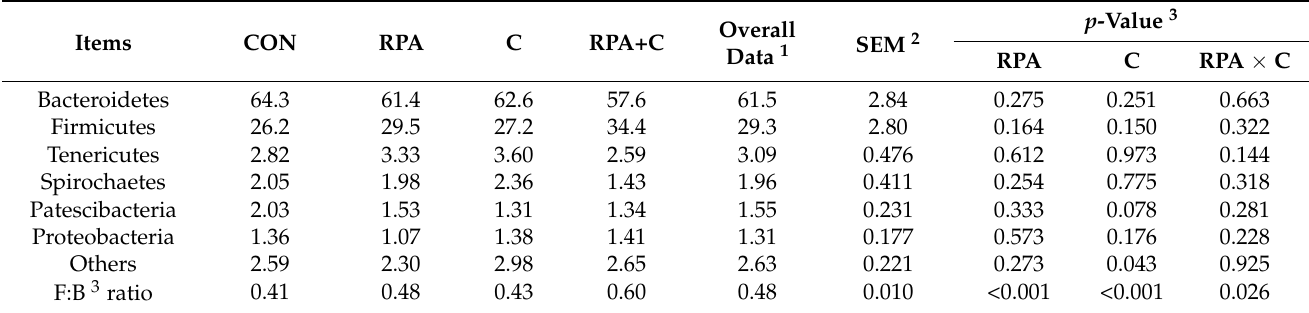
Table 3. Relative abundances (percentage of total reads) of rumen bacteria at phylum level in grazing, lactating yaks offered supplementary feeds.